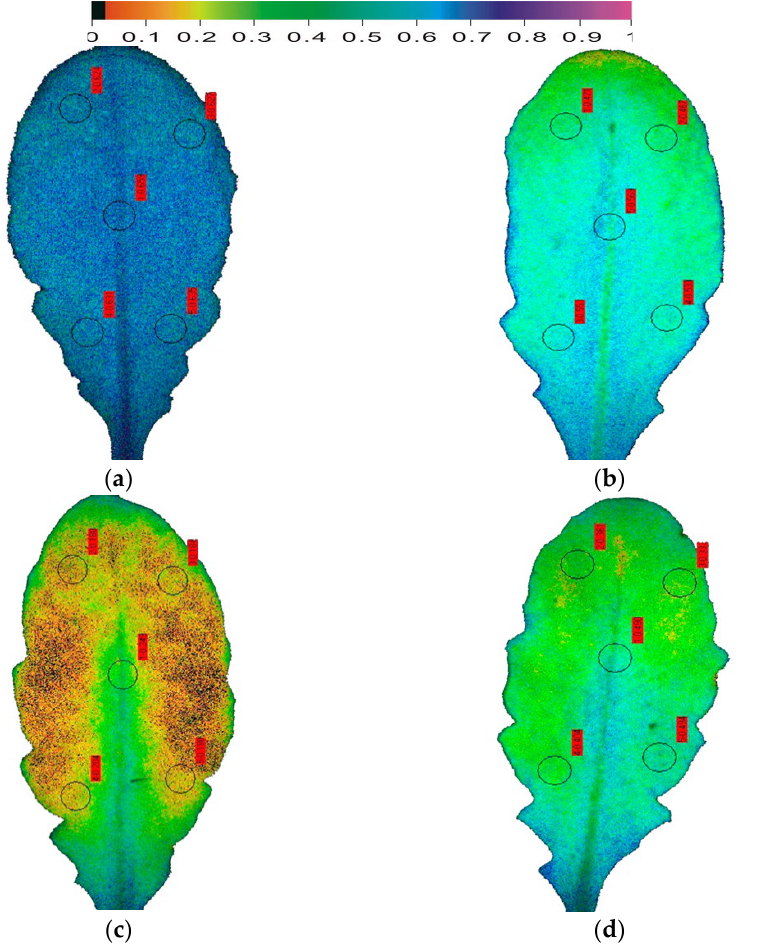
Figure 4. Color-coded images of the fraction of open PSII reaction centres ( q p = [F m ′ − F s ]/[F m ′ − F o ′ ]), representing the redox state of Q A , in Arabidopsis thaliana leaves. The fraction of open PSII reaction centres ( q p) decreased from the control value of 0.635 ( a ), with the onset of drought stress (OnDS, 24 h DS) to 0.519 ( b ), under mild drought stress (MiDS) decreased further to 0.218 ( c ); while under moderate drought stress (MoDS), q p recovered to 0.416 ( d ).